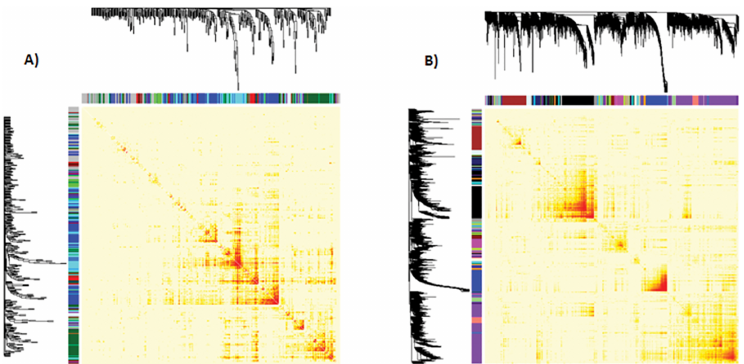
Fig 4. Dendrogram and heatmap of DEGs found under cold and drought stress in A . thaliana . The heatmap describes the Topological Overlap Matrix (TOM) for all DEGs used for co-expression network analysis. Color ranges from darker red to light red according to overlap i.e. higher to low and darker red color blocks along the diagonal are the modules. The gene dendrogram and modules (as different color bars) are also shown along the left side and the top.